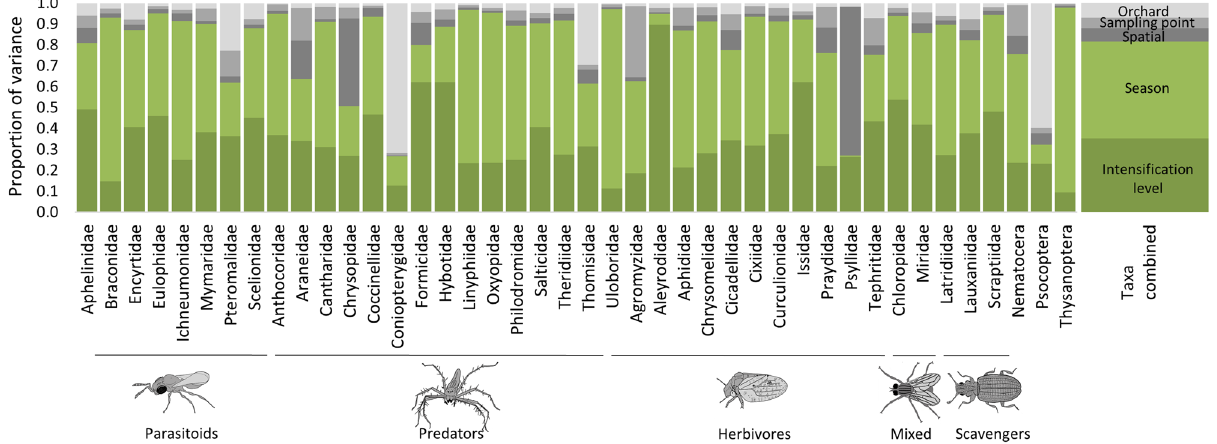
Figure 2. Proportion of variance in total arthropod abundance explained by orchard intensification level, season, sampling point-level, orchard-level and spatial random effects. The proportions of variance explained by fixed and random effects are shaded in tones of green and grey, respectively. Arthropod drawings by Juan Pablo Cancela.